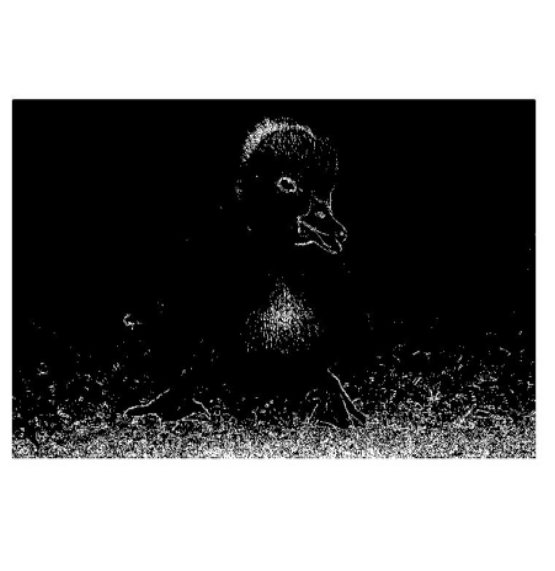
Figure 5.2 Segmented Monument Image